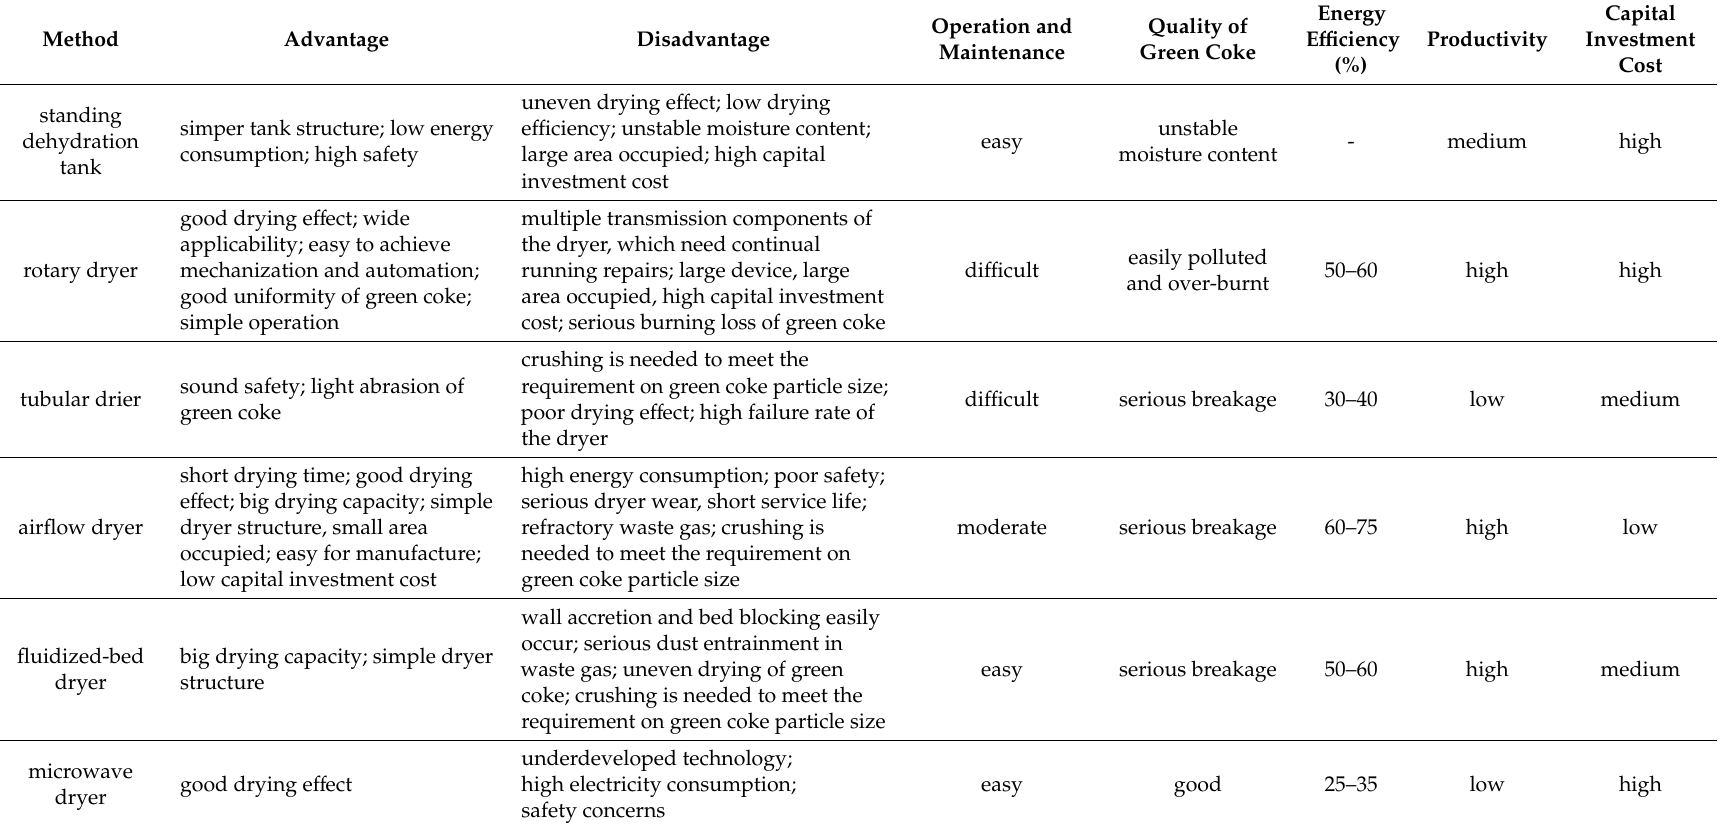
Table 1. Comparison of di ff erent green coke drying